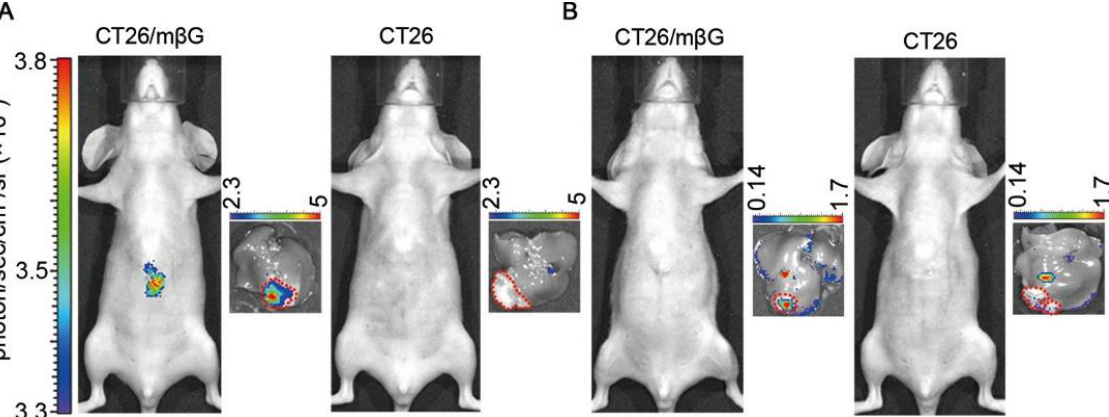
Figure 9. Imaging of CT26/mβG and CT26 cell -bearing mice with probes NIR-TrapG ( A ) and FITC-TrapG ( B ). Reprinted with permission from [50], copyright 2012 American Chemical Society